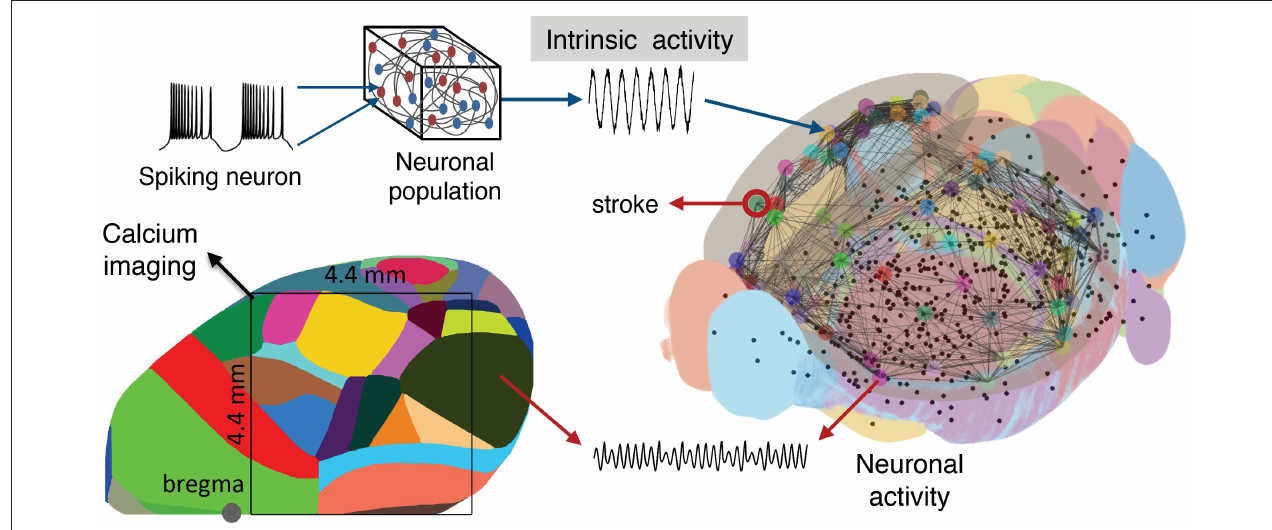
FIGURE 6 | Scheme of the mouse BNM. Brain Network Model consisting of neural masses superimposed over the AMBA connectome simulates the recorded calcium activity. The average oscillatory neuronal activity of the brain regions is described by Kuramoto oscillators, which are coupled due to the fiber tracts, giving rise to the simulated recordings. The brain network (right) is reconstructed from the AMBA, with the centers of subcortical regions being small black dots, while larger the circles are for the cortical regions, with the region of the stroke highlighted. (Left) The field of view during the recordings is overlayed on the reconstructed brain, and different colors represent the cortical regions according to the